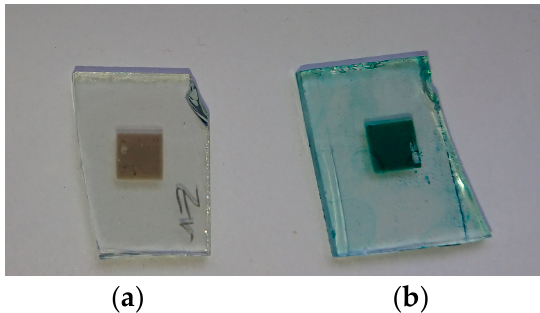
Figure 5. Photographs of DS_46-sensitized NiO film before ( a ) and after ( b ) the electrochemical cycling of Figure 4.